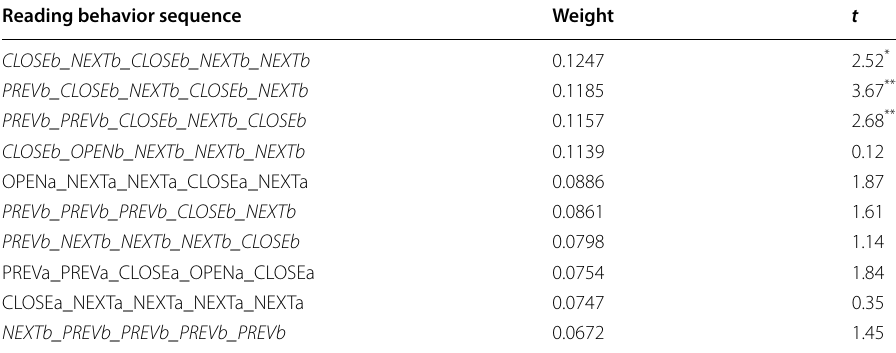
* p < 0.05, ** p < 0.01, *** p < 0.001